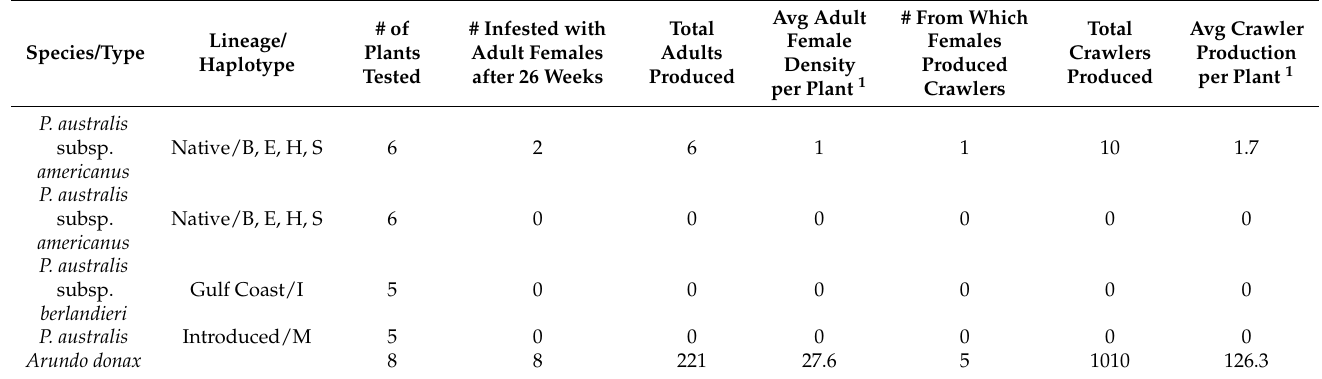
Table 3. Host Range Trials of R. donacis of known native range origin (Rivesaltes, France), focusing on haplotypes of Phragmites australis and Arundo donax. Plants were dissected for development of adult female scales after 6 months (26 weeks). Adult females were isolated from plants and crawler production was summed over 8